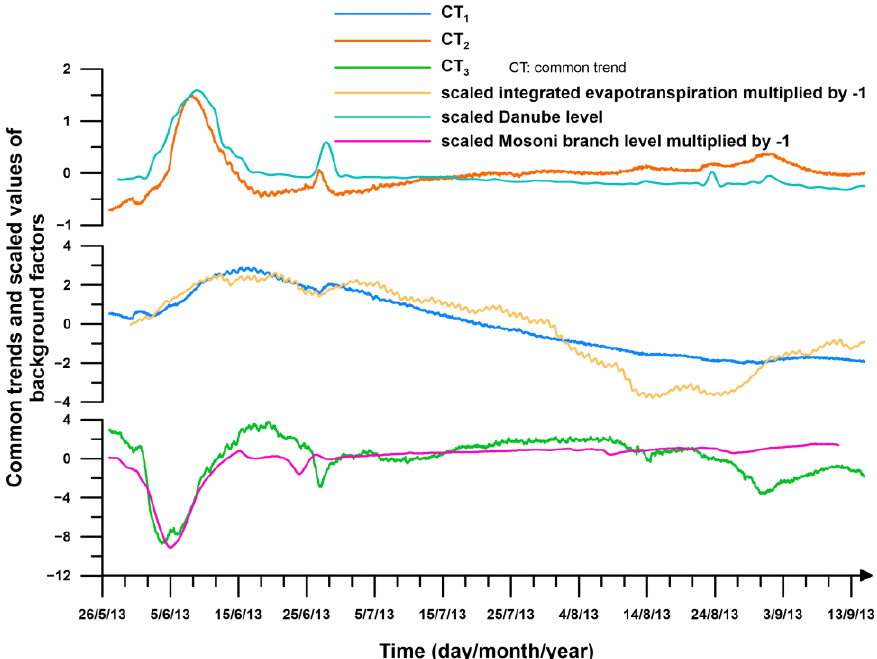
Figure 5. Common trends and the time series of background factors related to them in Szigetköz.